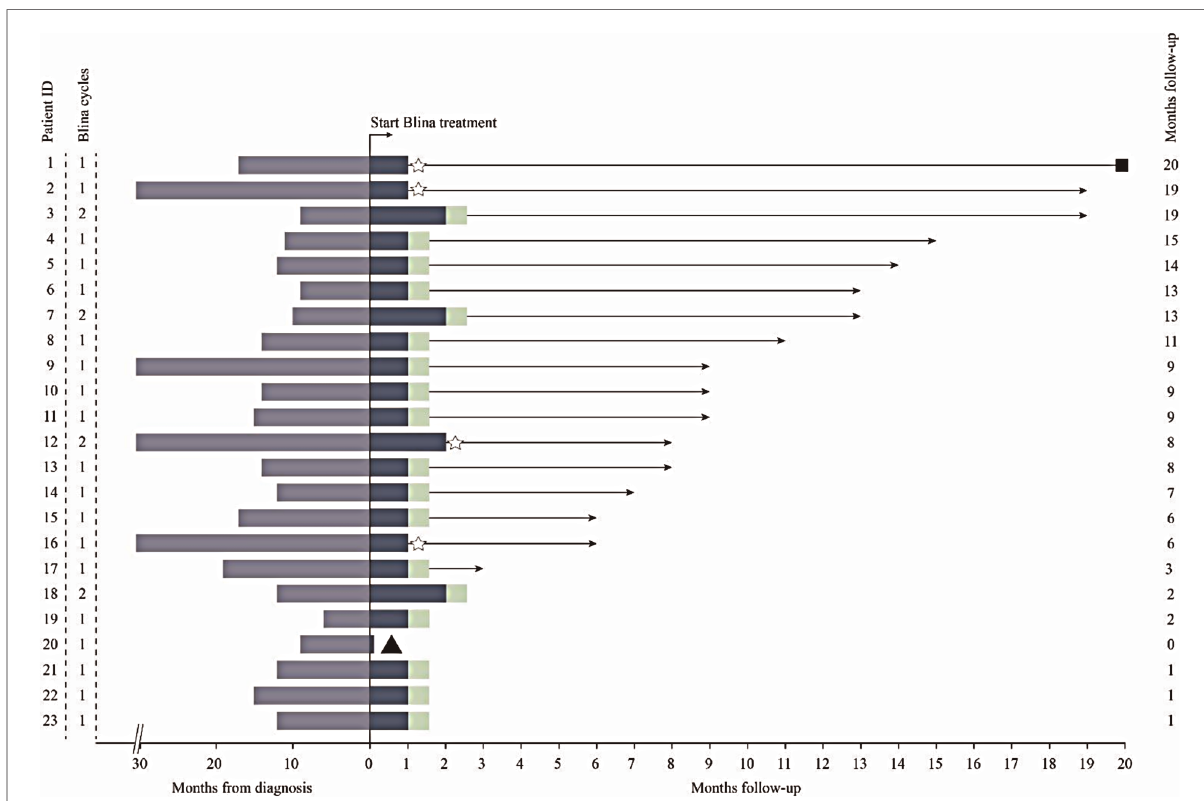
FIGURE 1 Clinical course of patients treated with blinatumomab (blina). Blue Shading , Time From diagnosis; Light Green Shading , bridge to maintenance therapy; Star , bridge to HSCT; Triangle , discontinuation of blinatumomab due to toxicity; Square ,